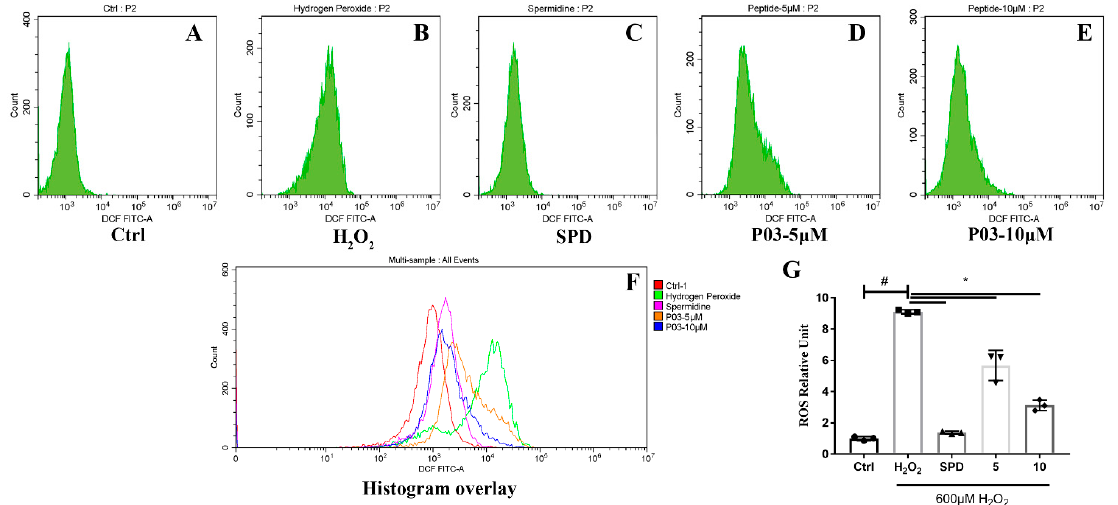
Figure 1. In vitro assays. ( A ) Viability of L02 cells with different concentrations of H 2 O 2 . ( B ) Viability of L02 cells damaged by H 2 O 2 after 24 h incubation of different concentration of peptide. ( C – G ) The cell cycle distribution in L02 cells with flow cytometry. ( H ) Quantitative analysis of cell cycle distribution in each group. ( I – P ) The apoptosis ratios of L02 cells in different groups with flow cytometry. ( Q ) Quantitative analysis of the percentage of cell apoptosis in each group. Comparisons were made with one-way ANOVA. Values were expressed as the percentage of the control and represented as mean ± SD. ( n = 3) (compared to Ctrl, # p < 0.05; compared to 0, * p < 0.05) ( n = 3). 2.2. P03 Supplementation Relieves Oxidative Stress in L02 Cells Damaged by H 2 O 2 L02 cells were labeled with DCFH-DA (2,7-dichlorodihydrofluorescein diacetate) to detect the levels of intracellular ROS with flow cytometry. The mean intensity of DCF (2,7- dichlorodihydrofluorescein) fluorescence was significantly increased to above eight-fold levels compared to that of the control group when L02 cells were exposed to H 2 O 2 (Figure 2B,G). The fluorescence intensity in the spermidine and P03 group was significantly lower at one to four-fold than that of the H 2 O 2 group. The quantification of ROS relative units further confirmed that the ROS levels of the L02 cells in the P03 group decreased compared to the H 2 O 2 group.